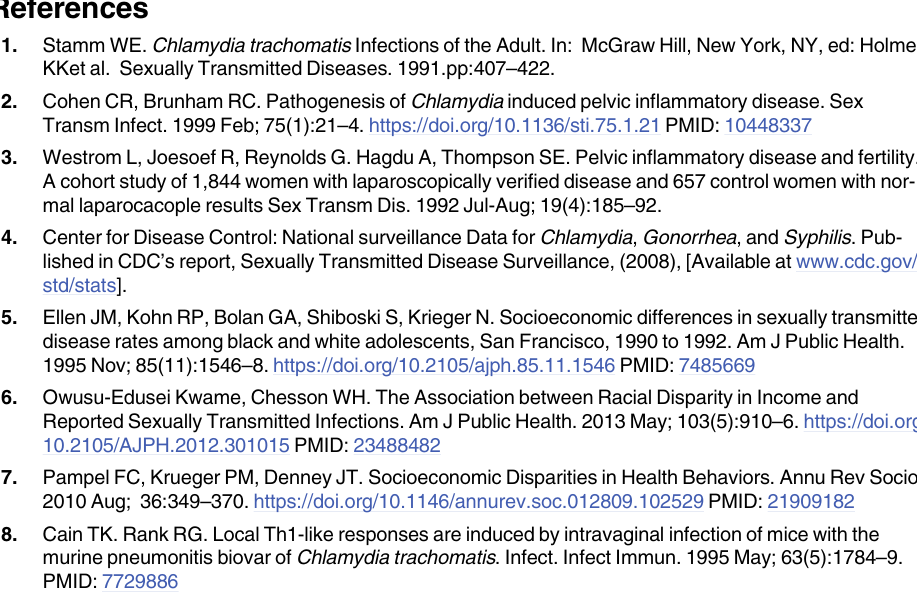
S3 Fig. Western blot analysis of transcription factors in CD4 T cells isolated from stressed and non-stressed mice with/without Chlamydia muridarum genital